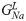
Interneurons from APdE9 mice are more depolarized in response to external stimulation as compared to interneurons from NTG mice.Membrane potential of interneurons during the last 200 ms window of the 500 ms long stimulus after removing the spikes in interneurons from the model as we change Gh (a) and GNaL (b) (lines). Observed values for interneurons from NTG (squares) and APdE9 mice (triangles) are shown for comparison. (c) and (d) are from the same simulations as (a) and (b) respectively except that here we show the ratio of depolarization in interneurons from NTG mice to those from APdE9 mice as a function of stimulus strength (lines and symbols are from the model and experiment respectively).